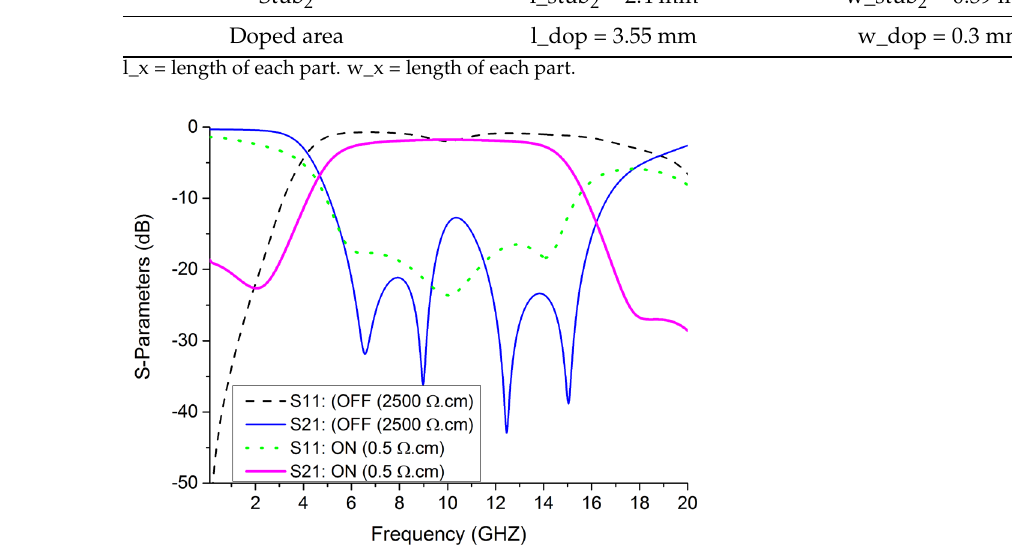
Figure 16. Simulated results of the 10 GHz filter in both states.